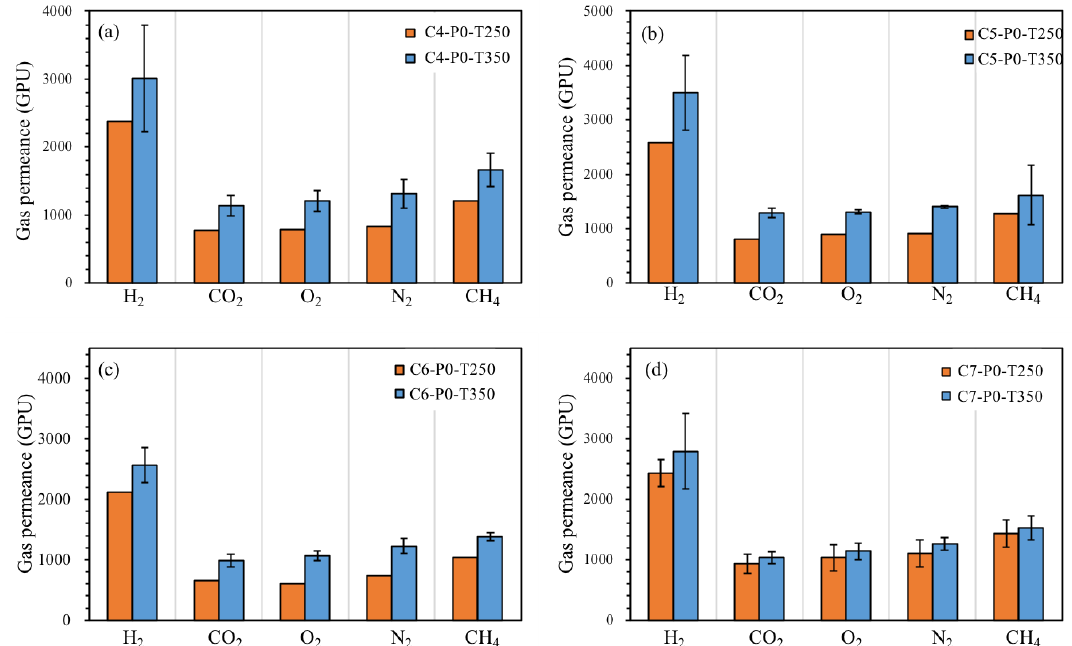
Figure 7. Single gas permeance of different gases obtained from resultant TR membranes with different heating temperatures. ( a : 4 wt % precursor; b : 5 wt % precursor; c : 6 wt % precursor; d : 7 wt % precursor).